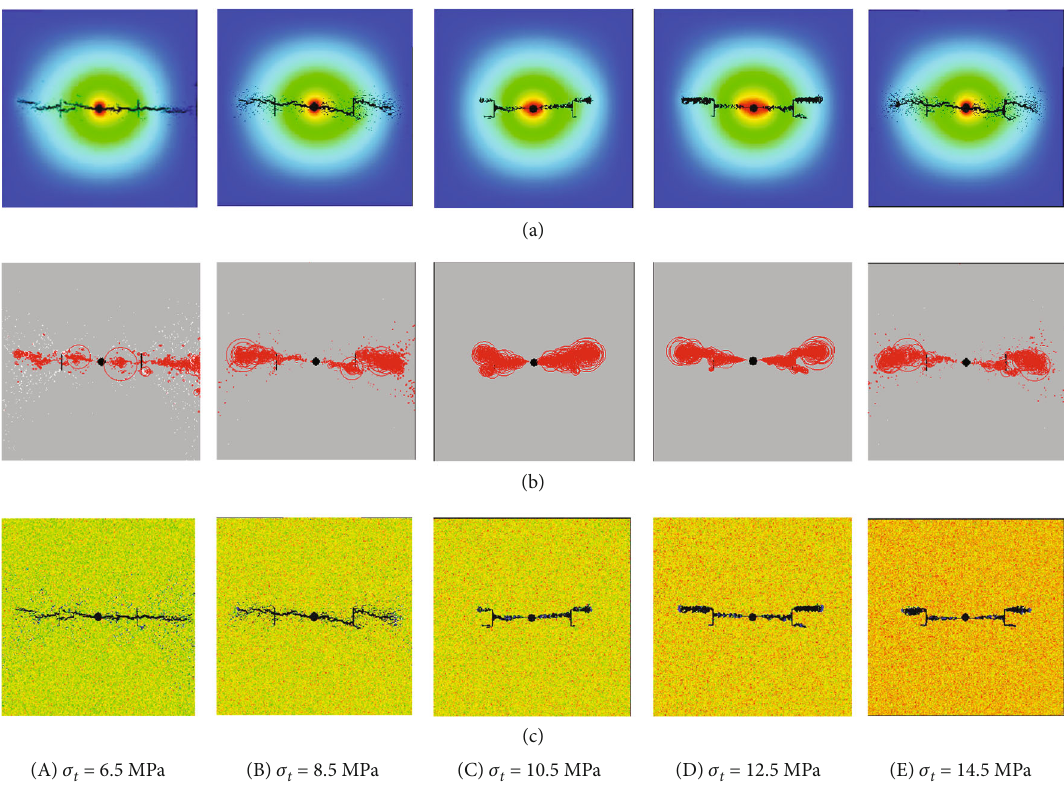
Figure 8: Process of hydraulic fracture propagation under di ff erent tensile strengths σ Acoustic emission signal. (c) Morphology of the hydraulic fracture